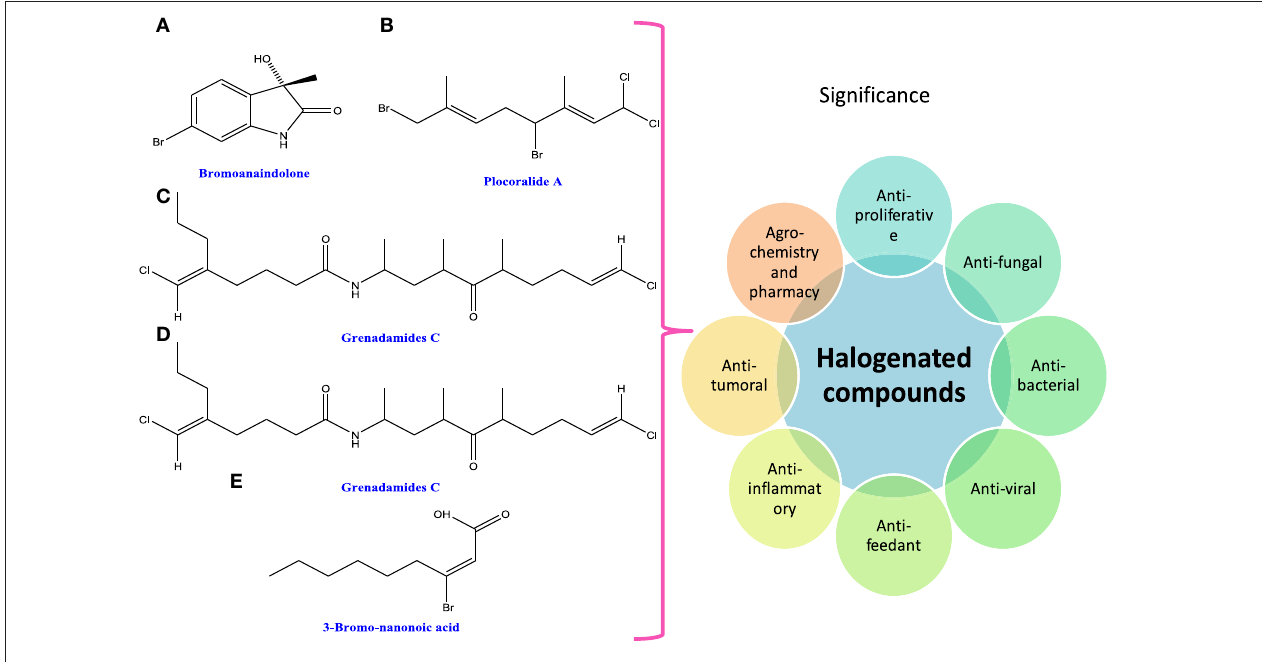
FIGURE 6 | Chemical structures and significance of halogenated compound: (A) bromoanaindolone, (B) plocoralide A, (C) grenadamides B, (D) grenadamides C, and (E) 3-bromo-nanonoic acid polymer obtained from different cyanobacteria and